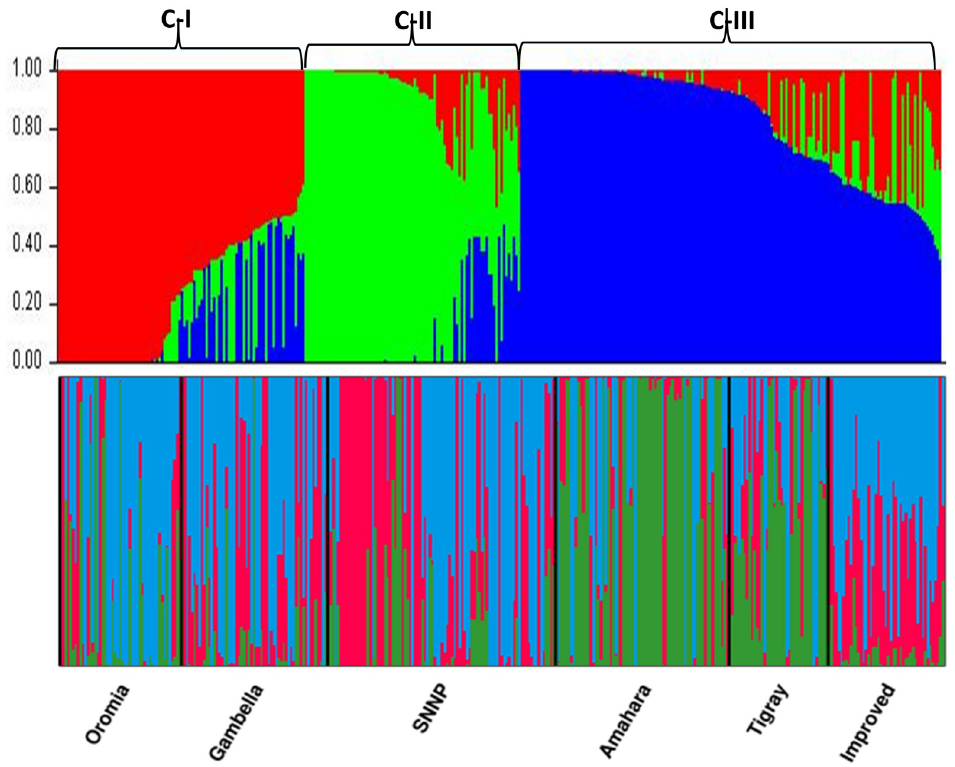
Fig 4. Population structure of 357 cowpea genotypes, in K = 3; each color represents one cluster.